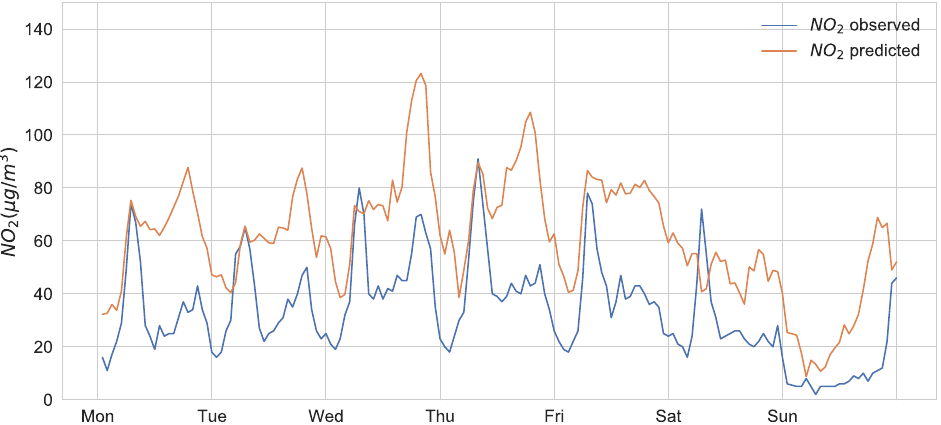
Figure 10. Comparison of the predicted and observed values of week 13 in 2020 during the COVID lockdown (23 to 30 of March).